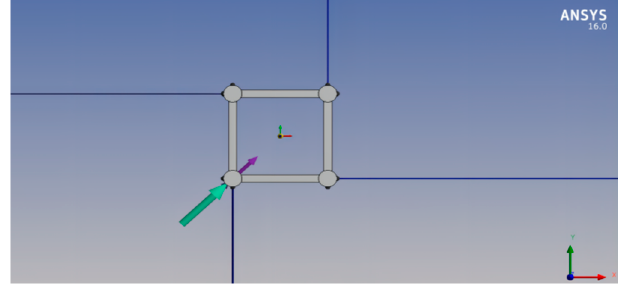
Figure 4. Plan of TLP with inclined tension legs.